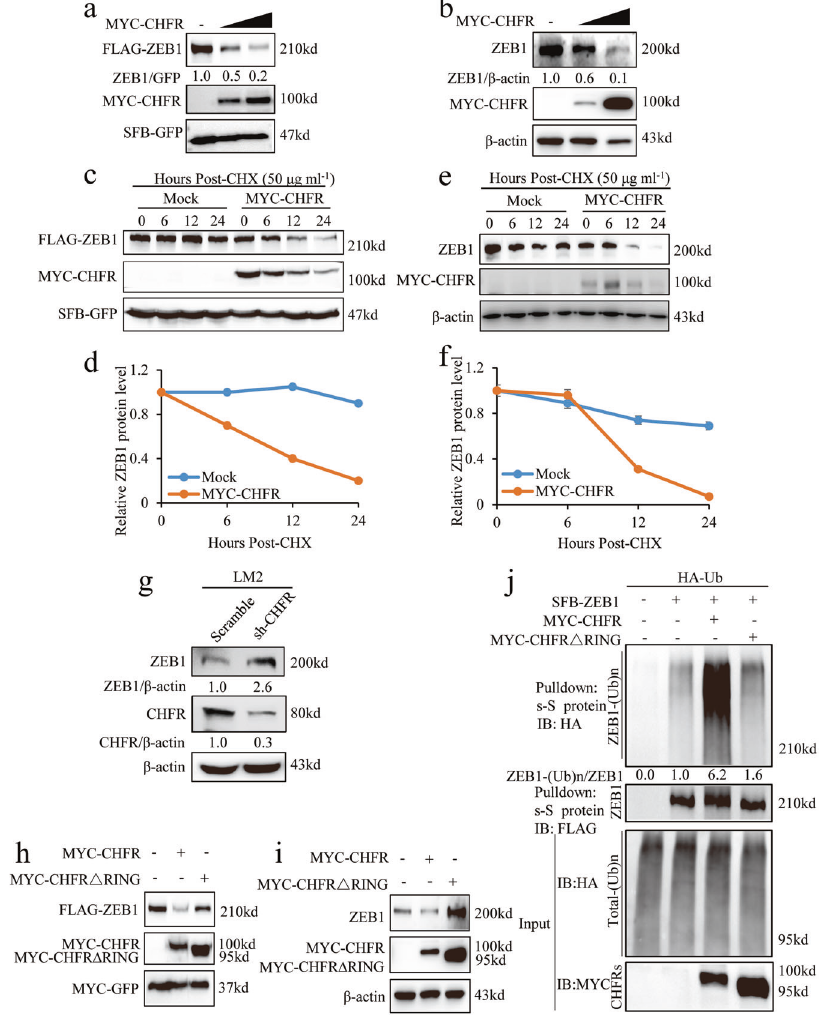
Fig. 2 CHFR is a ZEB1 E3 ligase. a Transiently transfected SFB-ZEB1 and different concentrations of MYC-CHFR in HEK293T cells and immunoblotted with the MYC and FLAG antibodies. b In SUM159 cells, different concentrations of MYC-CHFR were transfected, followed by immunoblotting with the antibodies as indicated. c , d SFB-ZEB1 and MYC-CHFR were transiently transfected into HEK293T cells, and 50 μ g ml − 1 CHX was added, and samples were collected at the indicated time points and analyzed by western blotting with FLAG and MYC antibodies. e , f In SUM159 stably expressed mock or CHFR cells, 50 μ g ml − 1 CHX was added, and samples were collected at the indicated time points, followed by immunoblotting with antibodies against ZEB1, MYC, and β -actin. g LM2 was transduced by scramble or sh-CHFR cells, and samples were collected and immunoblotted by ZEB1, CHFR, and β -actin antibodies. h Transiently transferred SFB-ZEB1, MYC-CHFR, or MYC- CHFR Δ RING into HEK293T cells. Immunoblotting of MYC and FLAG. i Transiently transfected MYC-CHFR or MYC-CHFR Δ RING into SUM159 cells, followed by immunoblotting of ZEB1, MYC, and β -actin. j HEK293T cells were transiently transfected with SFB-ZEB1, MYC-CHFR, or MYC-CHFR Δ RING and added MG132 for 6 h before collecting samples, followed by pulling down with s-S protein beads and immunoblotting of MYC, HA, and